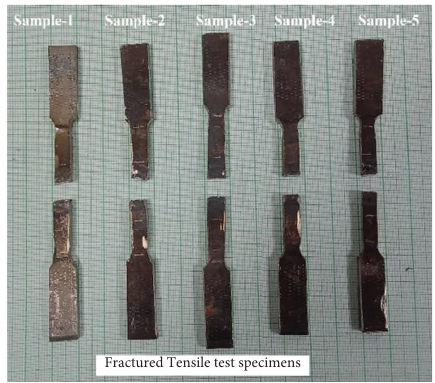
4: Broken tensile test